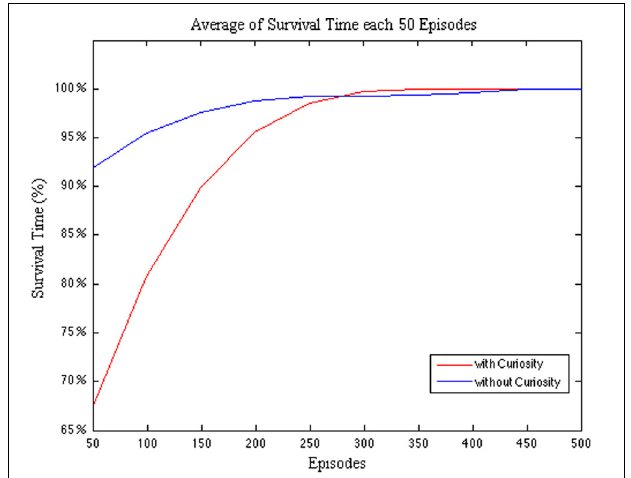
FIGURE 6 | Comparison between CR and NCR systems with respect to the survival time percentage per Episode. The survival time is averaged every 50 episodes.